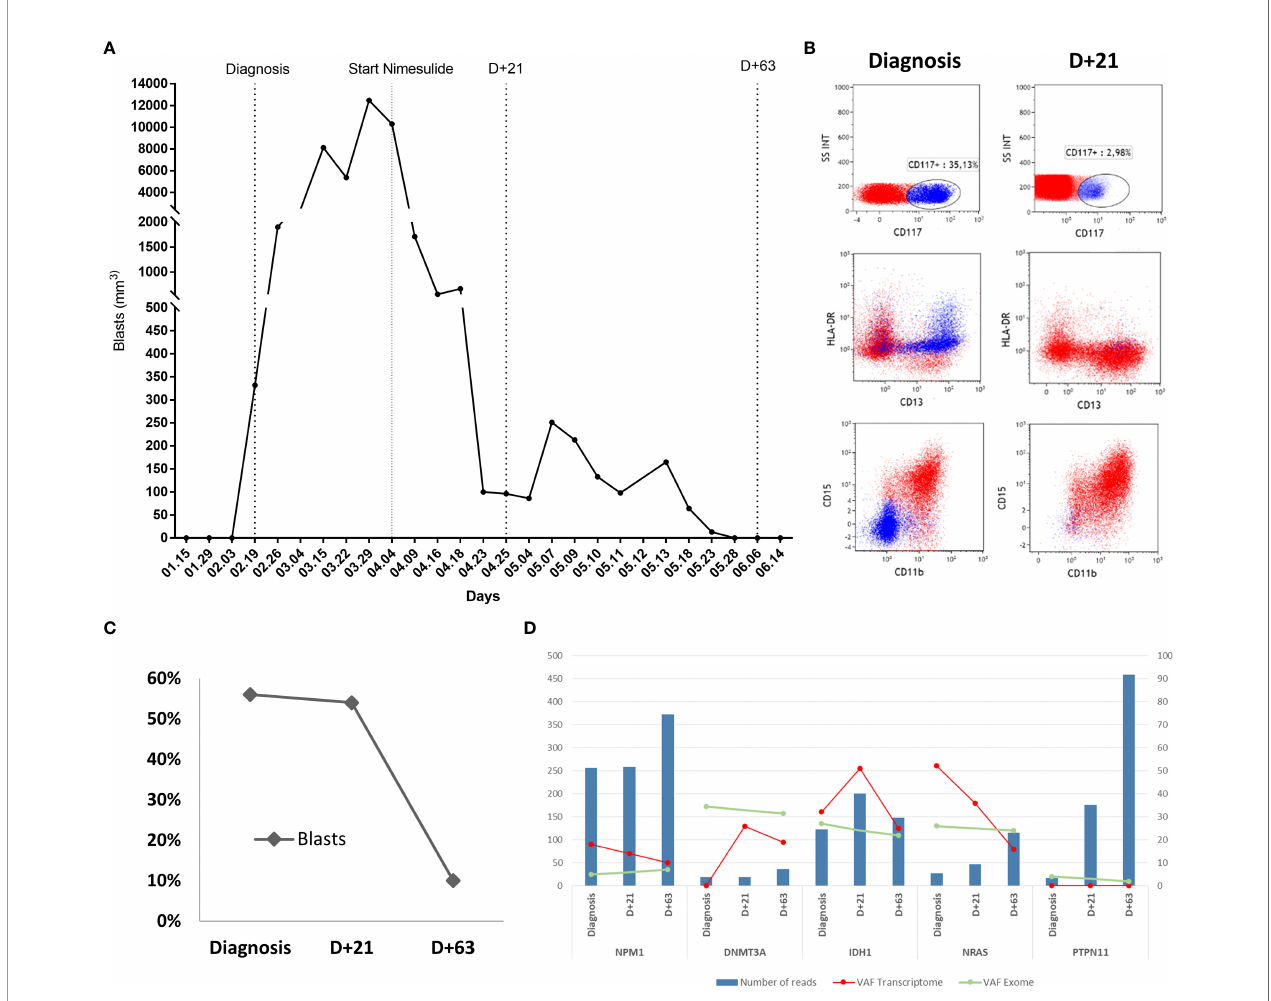
FIGURE 1 | Patient's response to the use of nimesulide. (A) Graph of absolute values of blasts in the patient ’ s peripheral blood at diagnosis and after starting nimesulide use. (B) Dot plot graphs of the expression of HLA-DR, CD117, CD15, CD13, and CD11b markers in the patient's bone marrow leukemic blast population at diagnosis and D+21 after starting nimesulide. (C) Percentage of blasts in the patient's bone marrow at diagnosis and after days of nimesulide use (D+21 and D+63). (D) Graph showing the total number of reads (reads coverage) of NPM1, DNMT3A, IDH1, NRAS, and PTPN11 in the patient's three transcriptomes (Diagnosis, D+21, and D+63) represented in the bars in blue and the allelic frequency of variants (VAF) of the respective mutations from transcriptomes (red line) and whole-exome sequencing (green line). The left y- axis represents the values of the numbers of reads (blue bars), and the right y-axis refers to the transcriptome (red line) and exome (green line) VAF